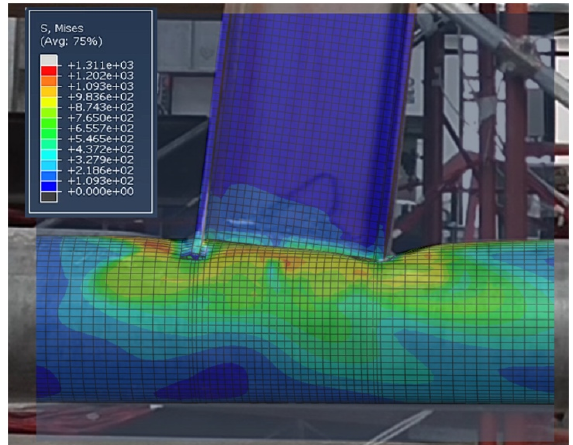
Figure 10. Overlap of FE and experimental results.